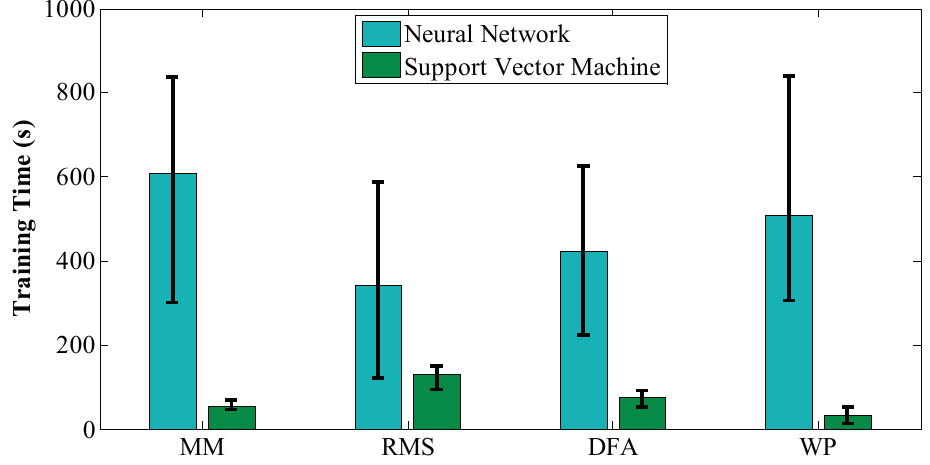
Figure 4. Time consumption of off-line training process. Blue bars show the average training time using NN with different features on all the subjects. Green bars show the results with SVM.